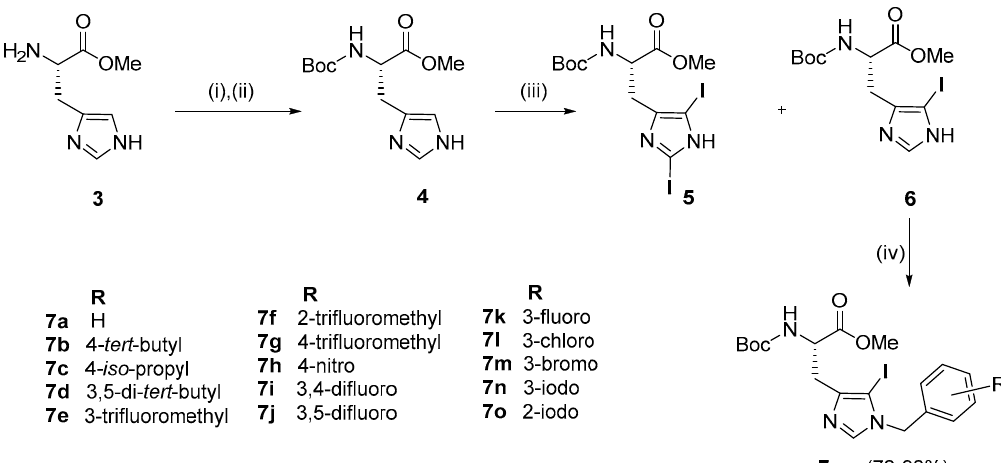
Scheme 1. Synthesis of N -benzylated 5-iodohistidine